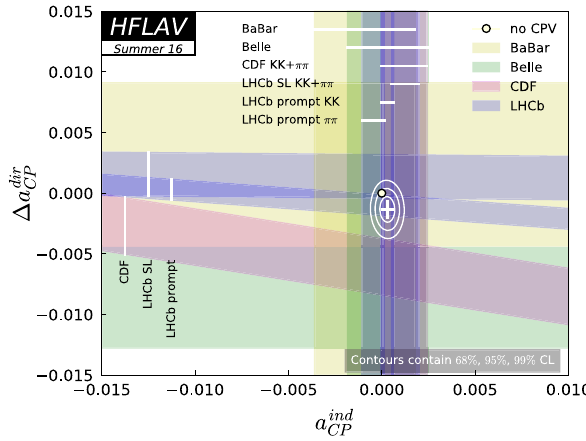
Fig. 198 Plot of all data and the fit result. Individual measurements are plotted as bands showing their ± 1 σ range. The no- CPV point (0,0) is shown as a filled circle, and the best fit value is indicated by a cross showing the one-dimensional uncertainties. Two-dimensional 68% C.L., 95% C.L., and 99 . 7% C.L. regions are plotted as